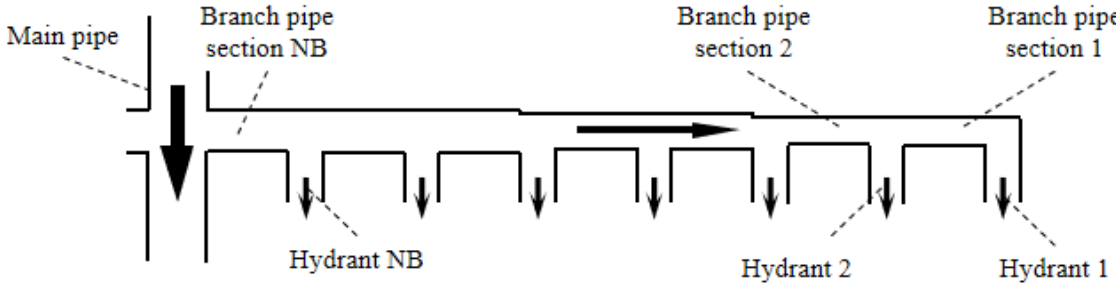
Figure 3. Schematic diagram of the branch pipe segments number and hydrant number.